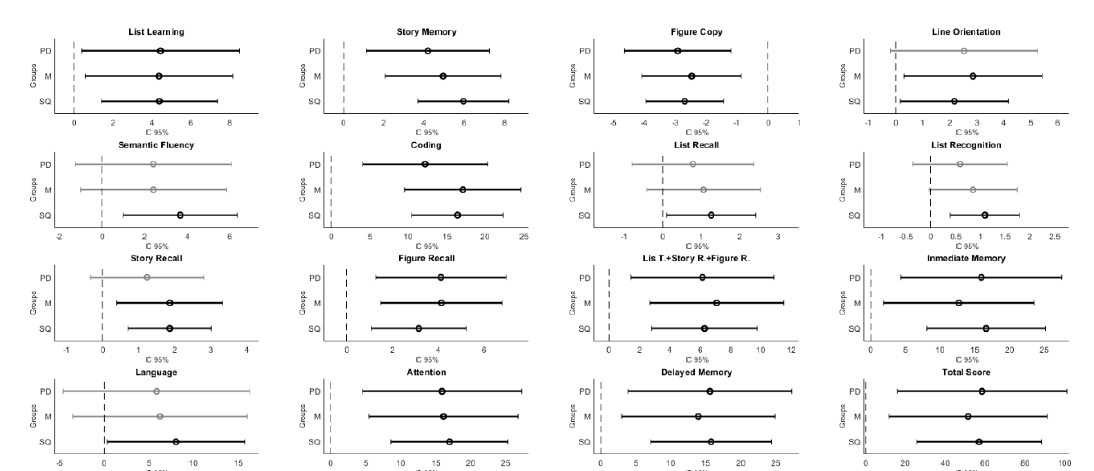
Figure 1. PD: Borderline Personality Disorder; M : Mood Disorder; SQ : Schizophrenia. Significant confidence intervals after multiple comparison correction are shown in these figures. Black bold lines intervals represent those comparison between control group and pathological group that reminds significant, whereas grey ones, represent those in which there are not significant differences. The middle point shows the mean difference of intervals.